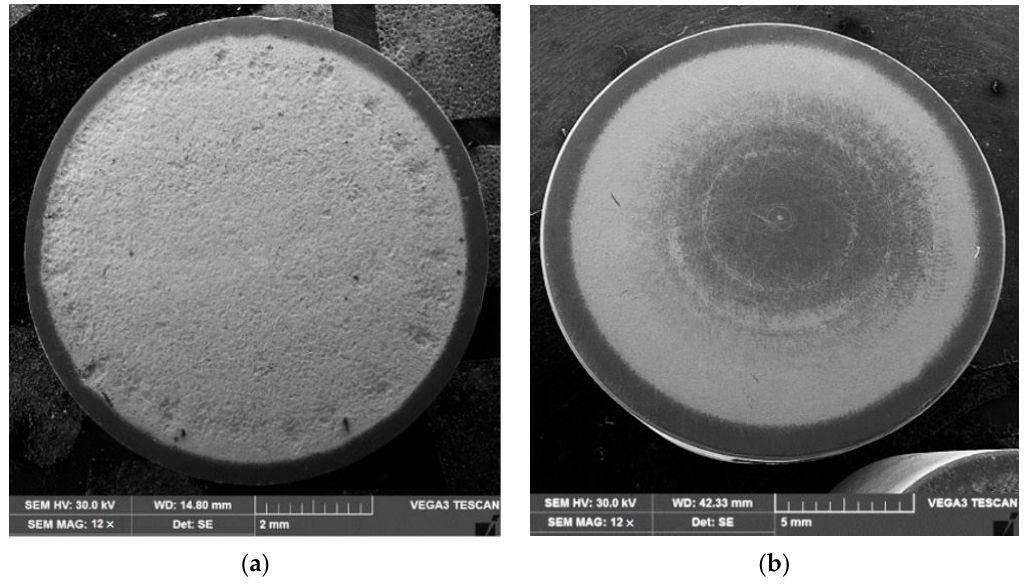
Figure 4. Macrographic images of the surfaces tested for 165 min cavitation time: ( a ) Reference material (solution-treated); ( b ) Solution-treated followed by nitriding.